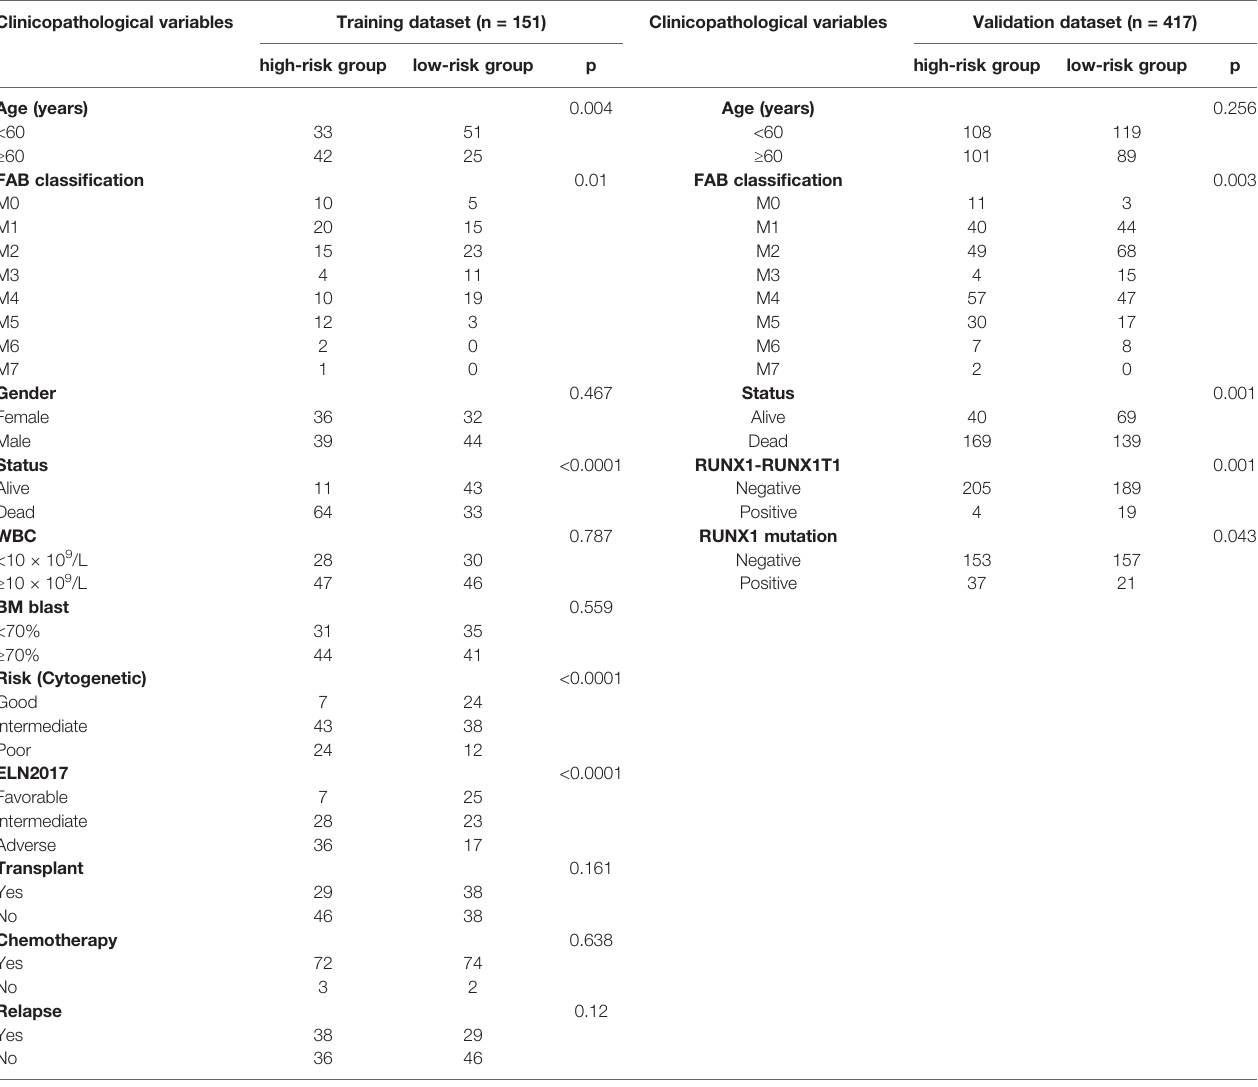
TABLE 1 | Baseline characteristics of the patients in the training and validation cohorts. Clinicopathological